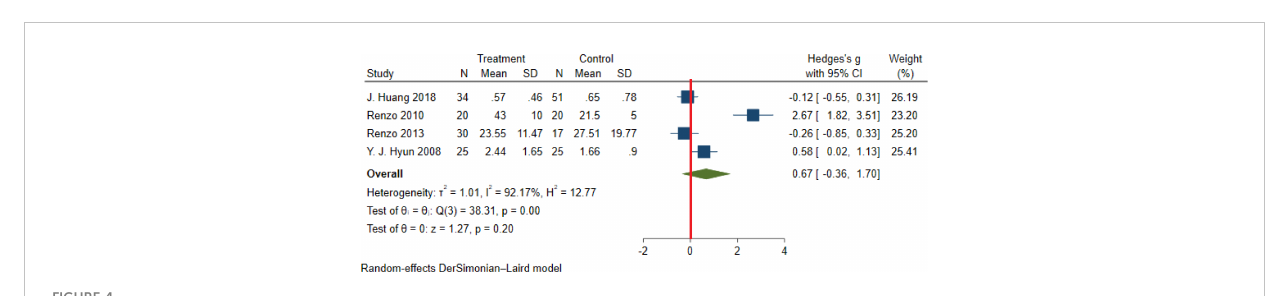
FIGURE 4 The extracted and overall association between NWO and TNF- a . (The red line represents null effect).